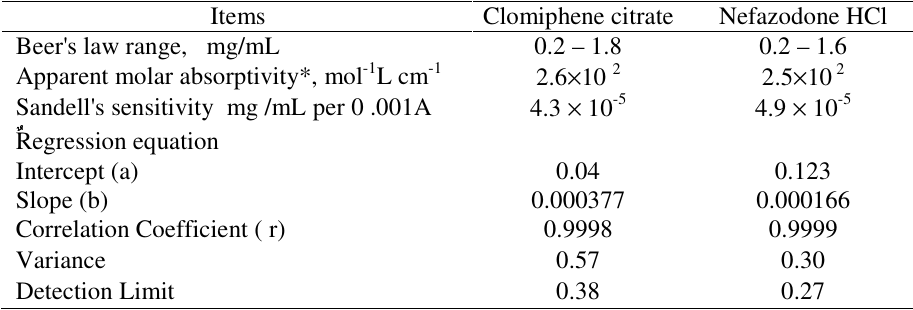
Table 1. Quantitative parameters for the spectrophotometric determination of clomiphene